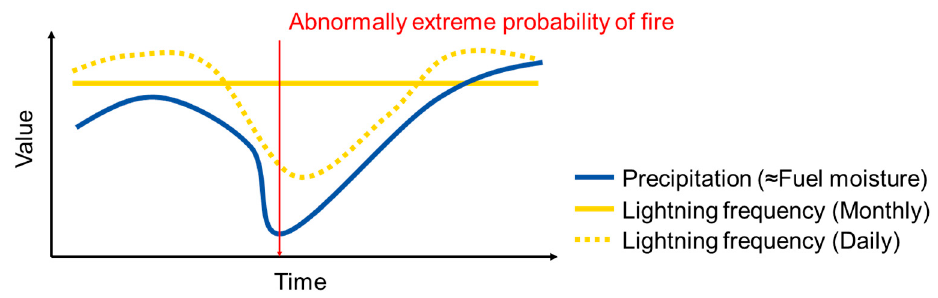
Figure 3. Conceptual illustration of potential overestimations of fire caused by the monthly lightning frequency and daily weather.